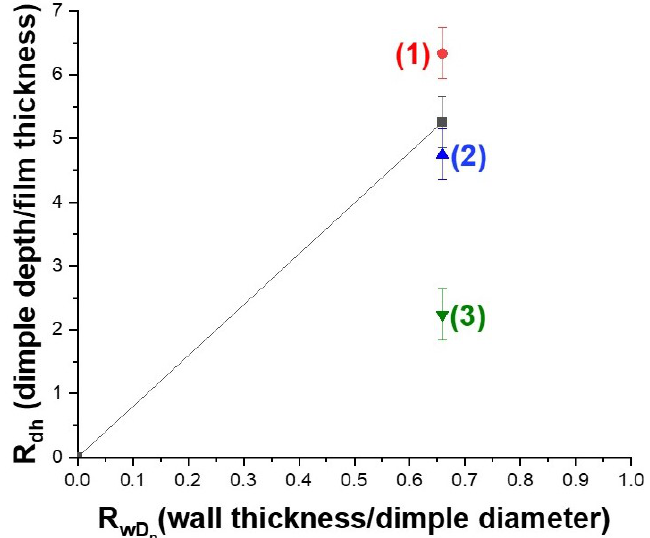
Figure 8. Dependence of nanoparticle morphology on metal film volume and dimple geometry. The trend line represents the condition in which the metal film volume is equal to the dimple volume. Three points labelled (1), (2) and (3) represent the location of R dh with respect to the trend line for films of thickness 6 nm, 8 nm and 17 nm, respectively.